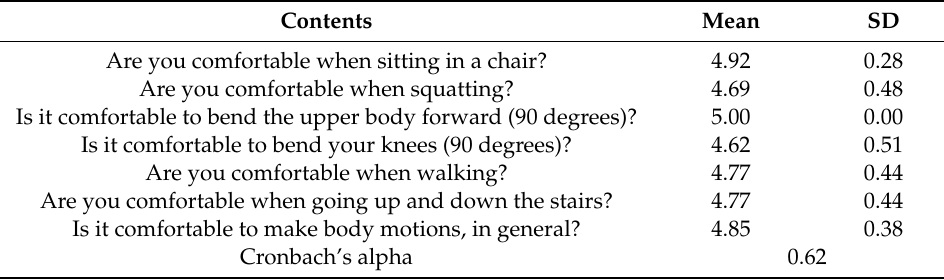
Table 9. Results of the evaluation of motion functionality ( n = 13).